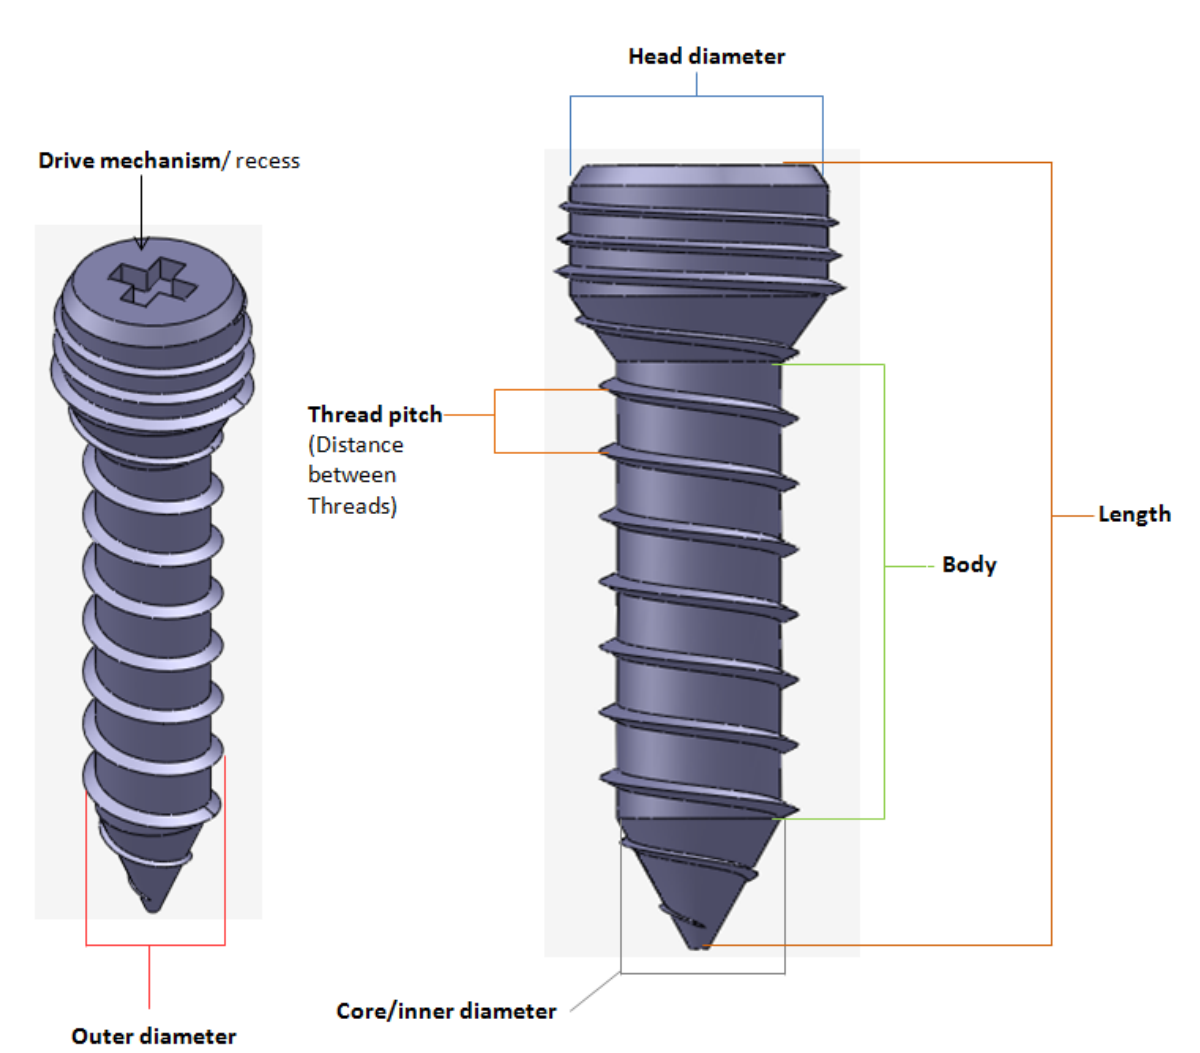
Figure 23. A custom-designed locking screw for TMJ prosthesis. Visuals show different features of the screw. Total length of the screw depends on the size of prosthesis and native bone. The body/shaft of screw is designed long enough to utilize maximum amount of host bone (condyle/ramus or fossa eminence) but avoid protrusion of screws from medial surface of the bone. Length of the screw head varies depending on the thickness of condylar or fossa prosthesis in the particular screw-hole location. The outer diameter of screw is kept in the range of 1.5 mm–3.00 mm as this range is reported to be optimal for the screws of TMJ implants. The screw has varying pitch, with more threads per unit length of screw-head than the body/shaft.